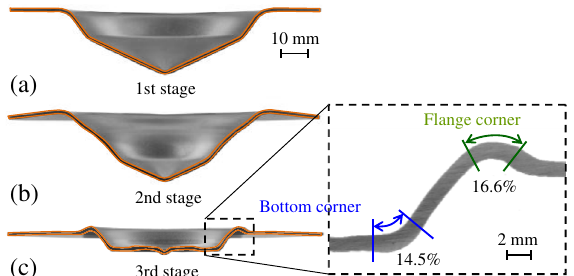
Figure 10. Cross-sections of cups for h = 40 (cid:3) and s 2 = 20 mm.